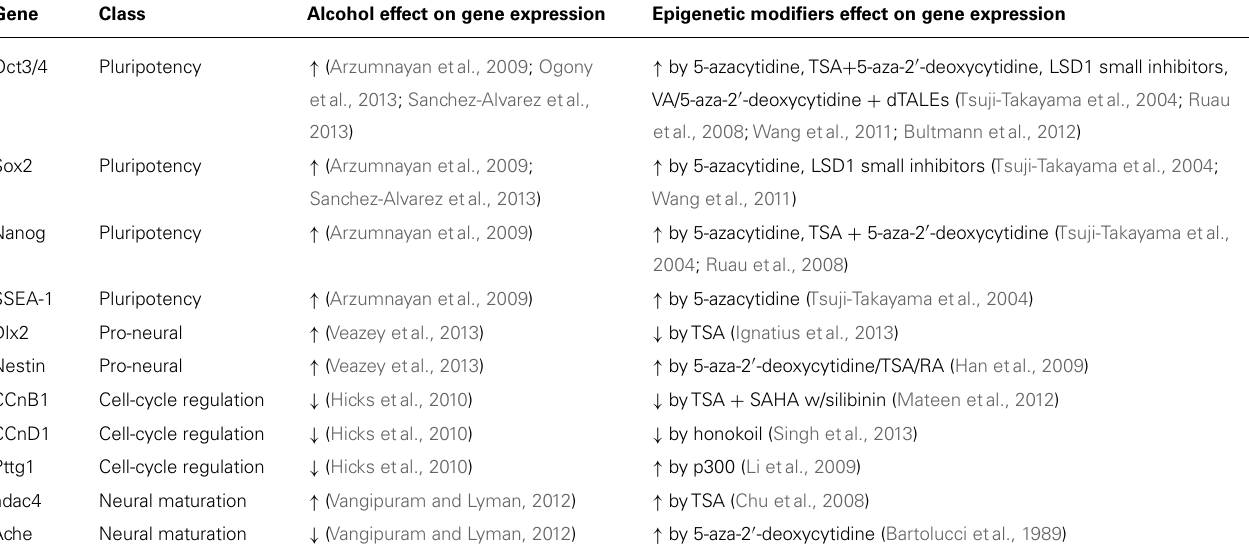
Table 1 | Neurodevelopmental genes as dual targets of alcohol and epigenetic